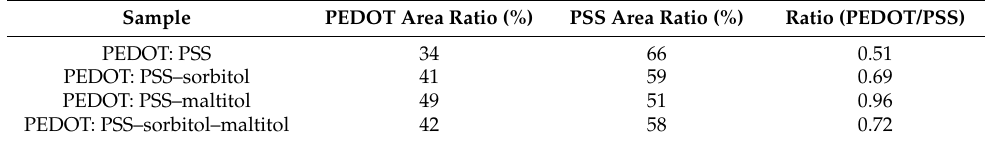
Figure 2. S (2p) peak of XPS spectra for ( a ) PEDOT: PSS, ( b ) PEDOT: PSS–sorbitol, ( c ) PEDOT: PSS– maltitol, and ( d ) PEDOT: PSS–sorbitol–maltitol. Table 1. The XPS (S 2p) area ratio of PEDOT: PSS doped with sorbitol and maltitol.